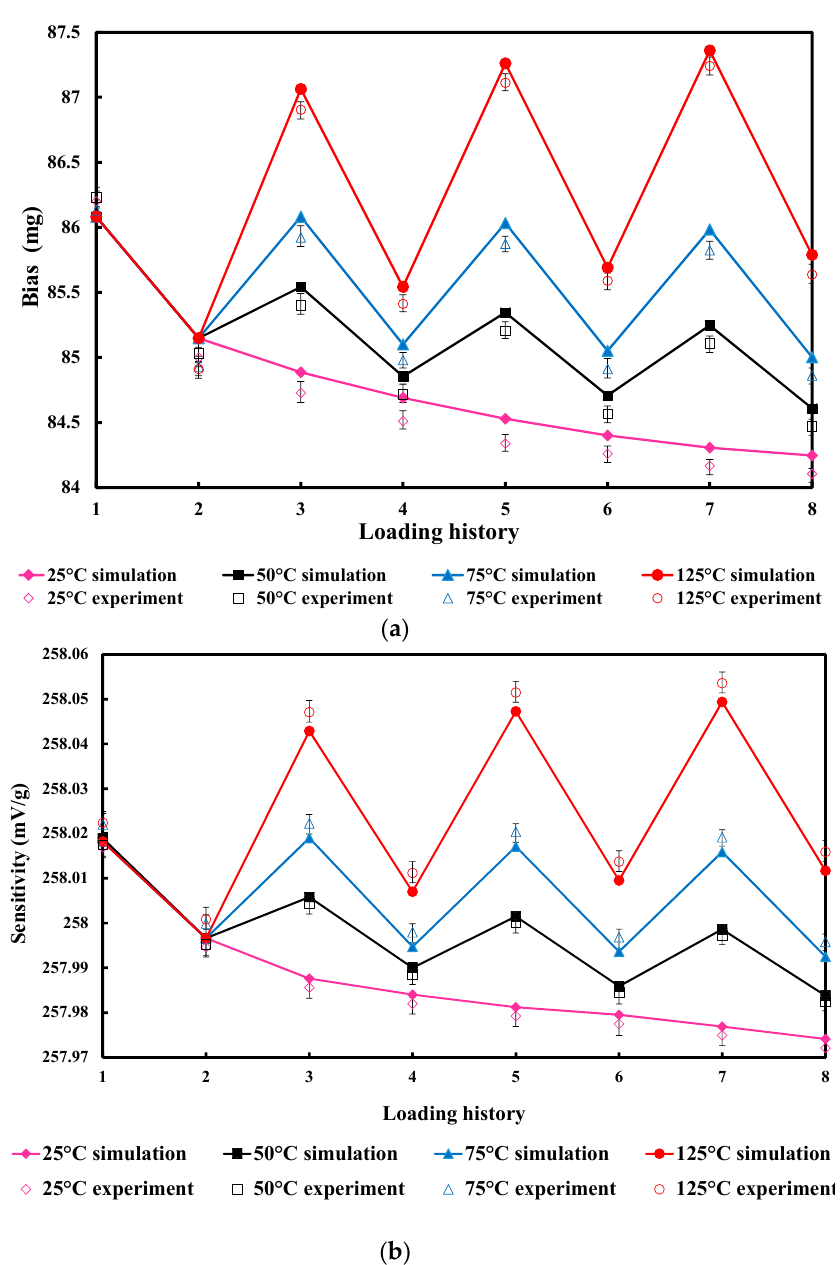
Figure 8. Results comparison. ( a ) Bias; ( b ) sensitivity.